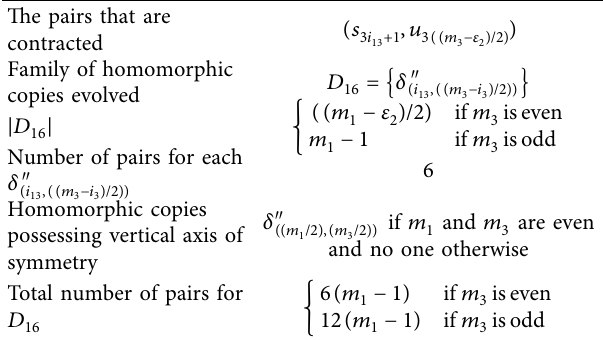
Table 16: Necessary information regarding homomorphic copies